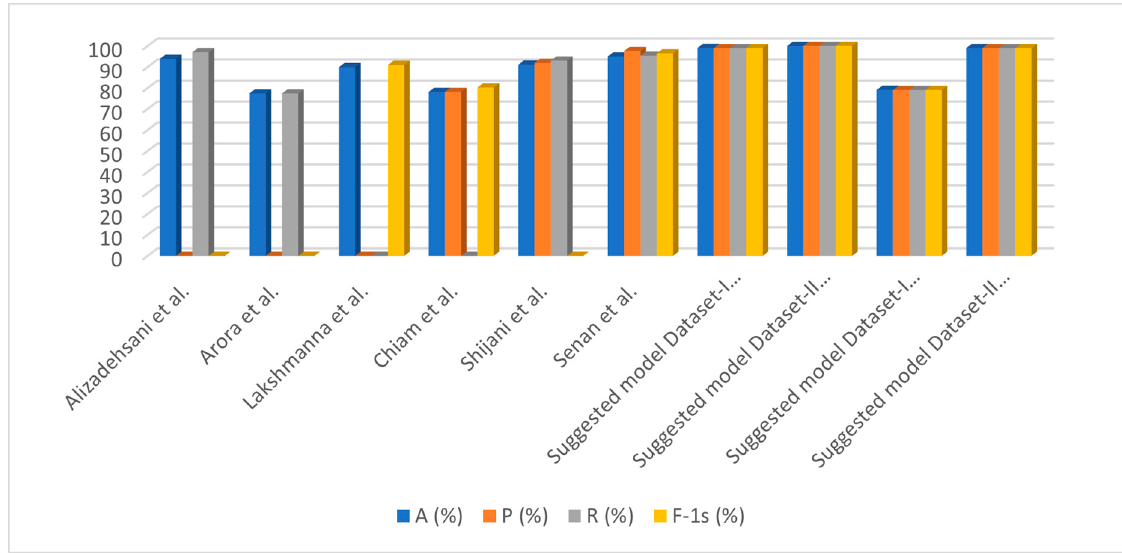
Figure 13. Graphical representation of the performance evaluation of the traditional system [35,36,37,38,39,40].